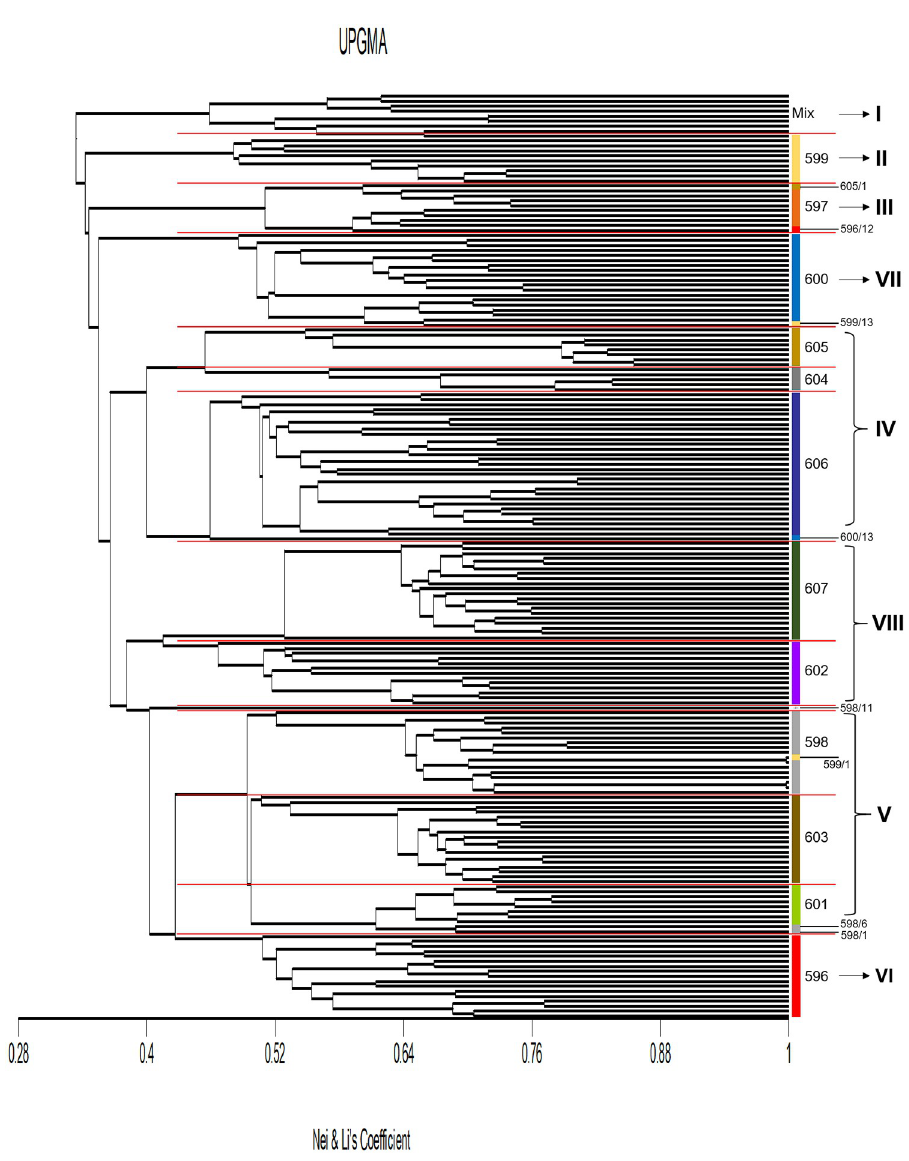
Fig 1. UPGMA dendogram based on Nei and Li’s